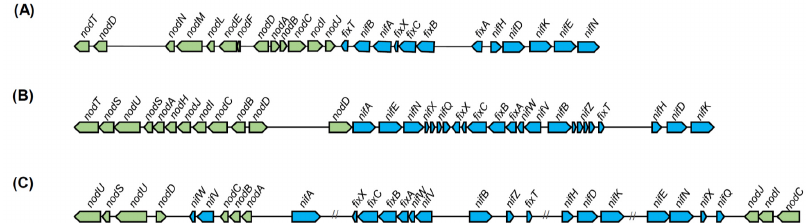
Figure 4. Schematic illustration of nod and nif/fix gene cluster organization in representative species: ( A ) α -rhizobia Rhizobium leguminosarum ; ( B ) the mimosoid-nodulator, Paraburkholderia phymatum ; and ( C ) the papilionoid-nodulator, Paraburkholderia tuberum . Nod genes are shown in green and nif/fix genes are in blue. The “//” symbol means an interruption by other genes, some of which are symbiosis-related. The annotation is adapted from De Meyer et al. [120].